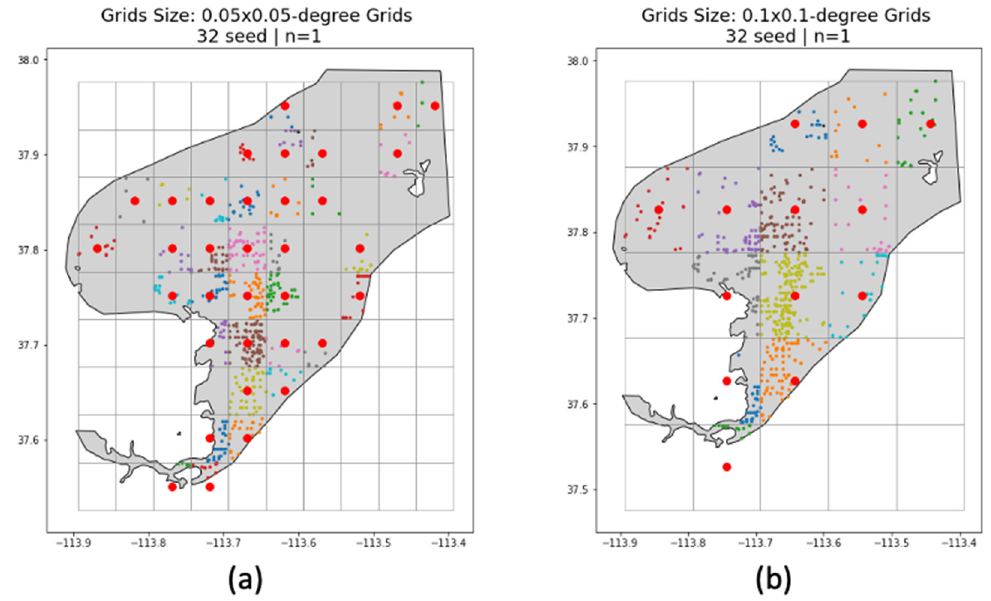
Figure 5. Well clusters and pseudo-wells for the grid method with ( a ) 0.05-degree cells and ( b ) 0.1-degree cells.